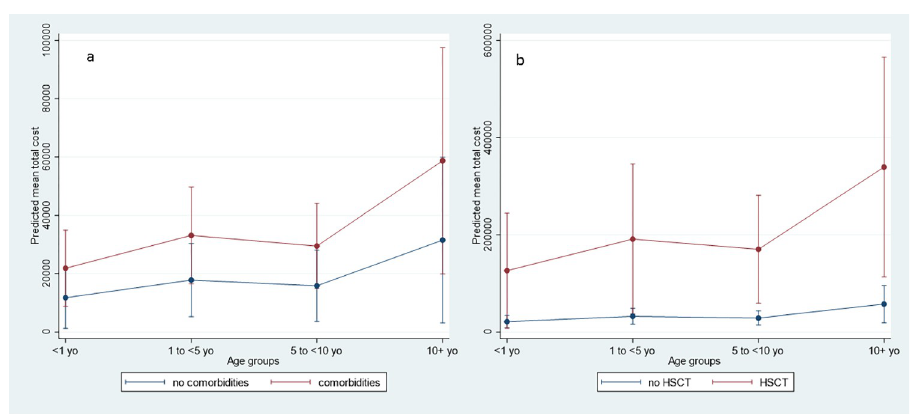
Fig 2. Total costs by age group for the presence of comorbidities (section a) and bone marrow transplant (section b).